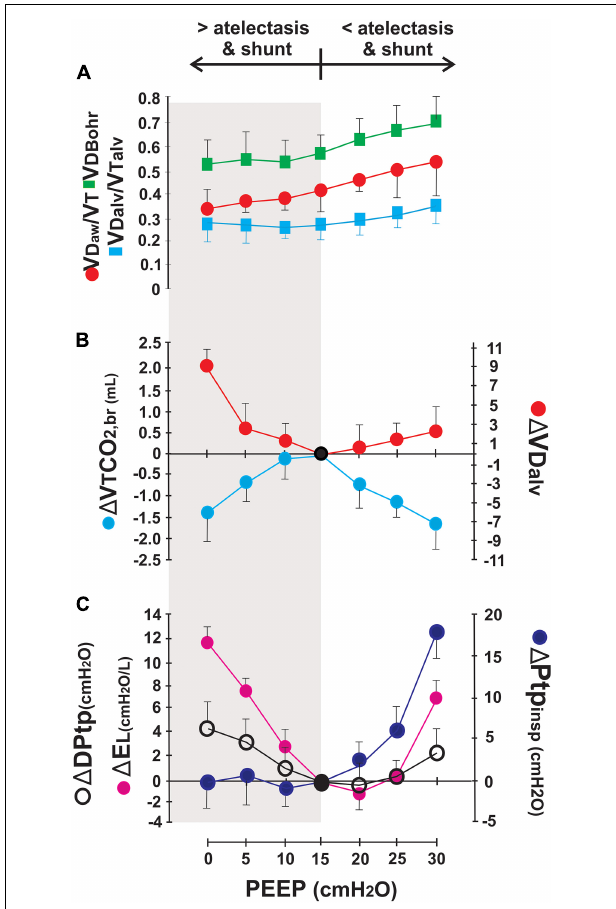
FIGURE 4 | Effects of PEEP in dead space and lung mechanics. Airway dead space increases in proportion to PEEP and has a direct impact on physiological Bohr’s VD. Alveolar dead space (VDalv), on the contrary, changes according to the balance between recruitment and overdistension in the alveolar compartment. Panel (A) shows the effect of PEEP on absolute dead space values. Panels (B,C) present the differences in alveolar dead space ( (cid:49) VD alv ), elimination of CO 2 per breath ( (cid:49) VTCO 2 , br ), transpulmonary driving pressure ( (cid:49) DPtp), transpulmonary end-inspiratory pressure ( (cid:49) Ptp insp ), and lung elastance ( (cid:49) E L ) between certain PEEP level with the reference15-PEEP considered as the “Best” PEEP according to findings in gas exchange, lung ultrasound, and respiratory mechanics adapted from Tusman et al.